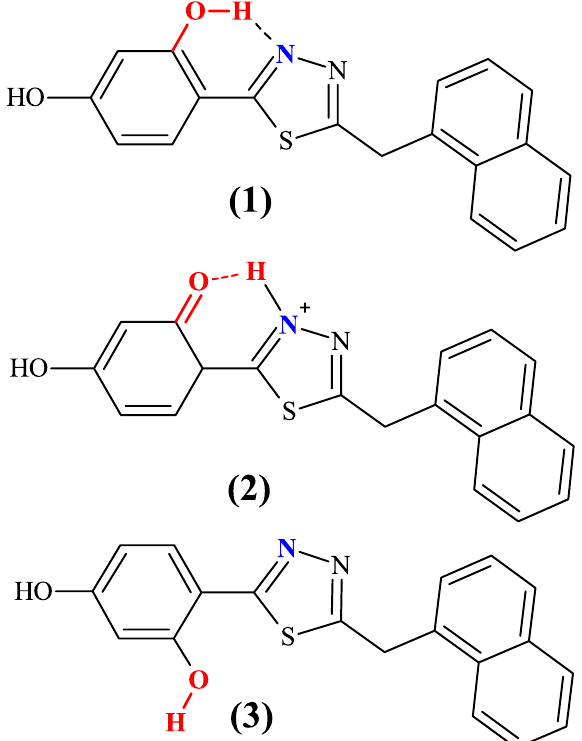
Figure 2. Keto-enol tautomerism and intramolecular hydrogen bonds in NTBD: cis configuration of enolic form ( cis -enol) favoring the formation of intramolecular hydrogen bond with the nearest thiadiazole nitrogen atom (1), keto form (2) trans configuration of enolic form ( trans -enol) in which the formation of intramolecular hydrogen bond is prevented